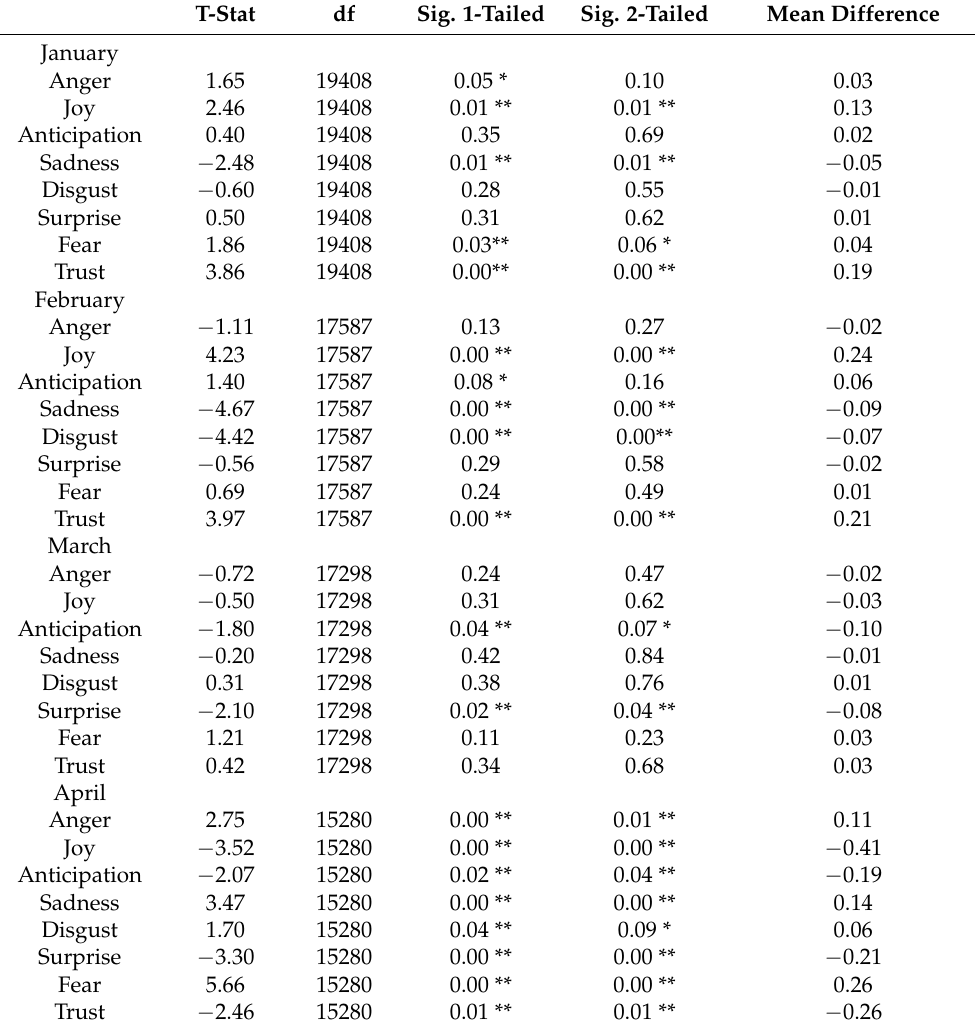
Table 2. t-test of eight emotions between 2020 and the average of 2017–2019 by month. T-Stat